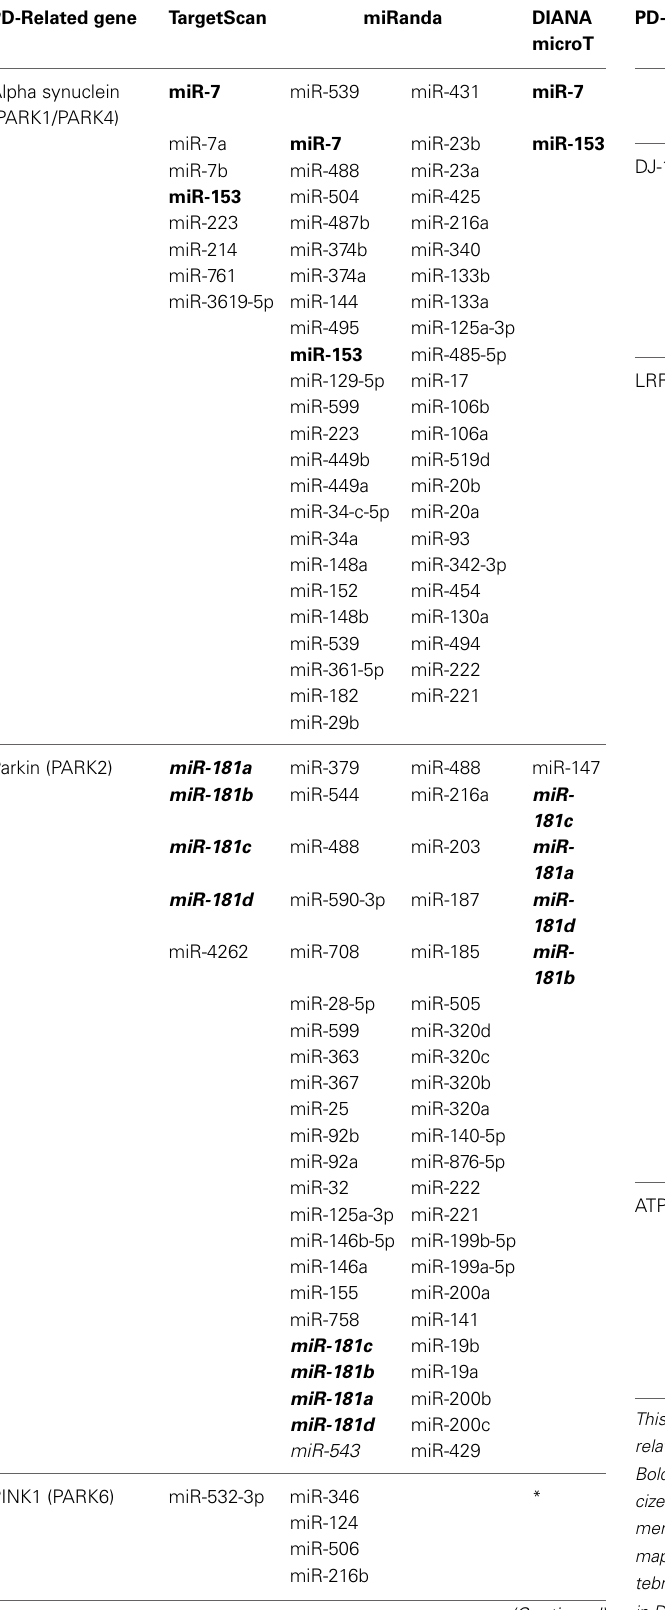
Table 2 | Putative miRNA targeting PD-related